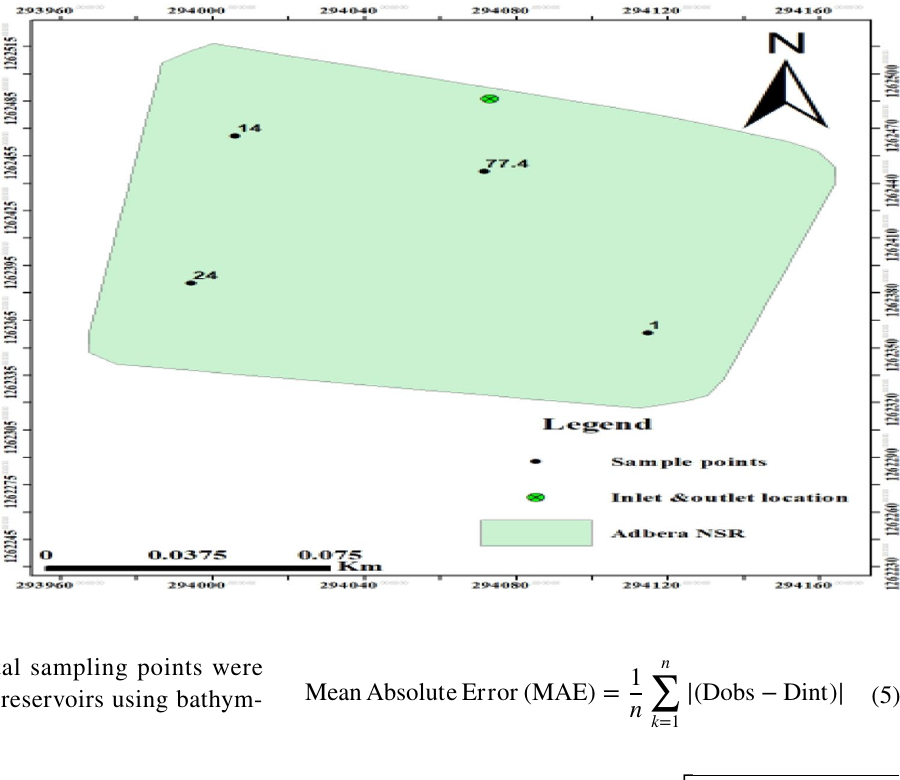
Fig. 5 Location of soil sampling with ID in Adebra